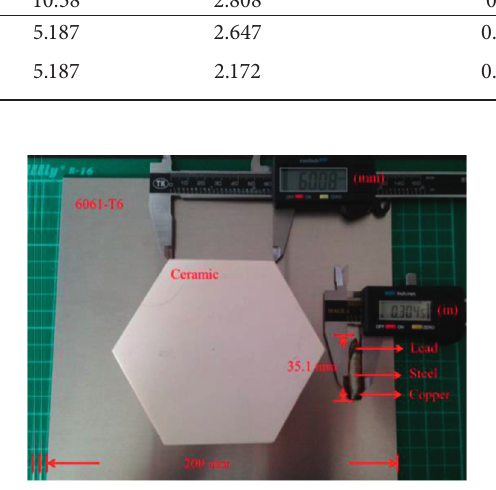
Figure 7: Prepared specimen and 0.30 ″ AP projectile. Table 2: Ballistic experimental